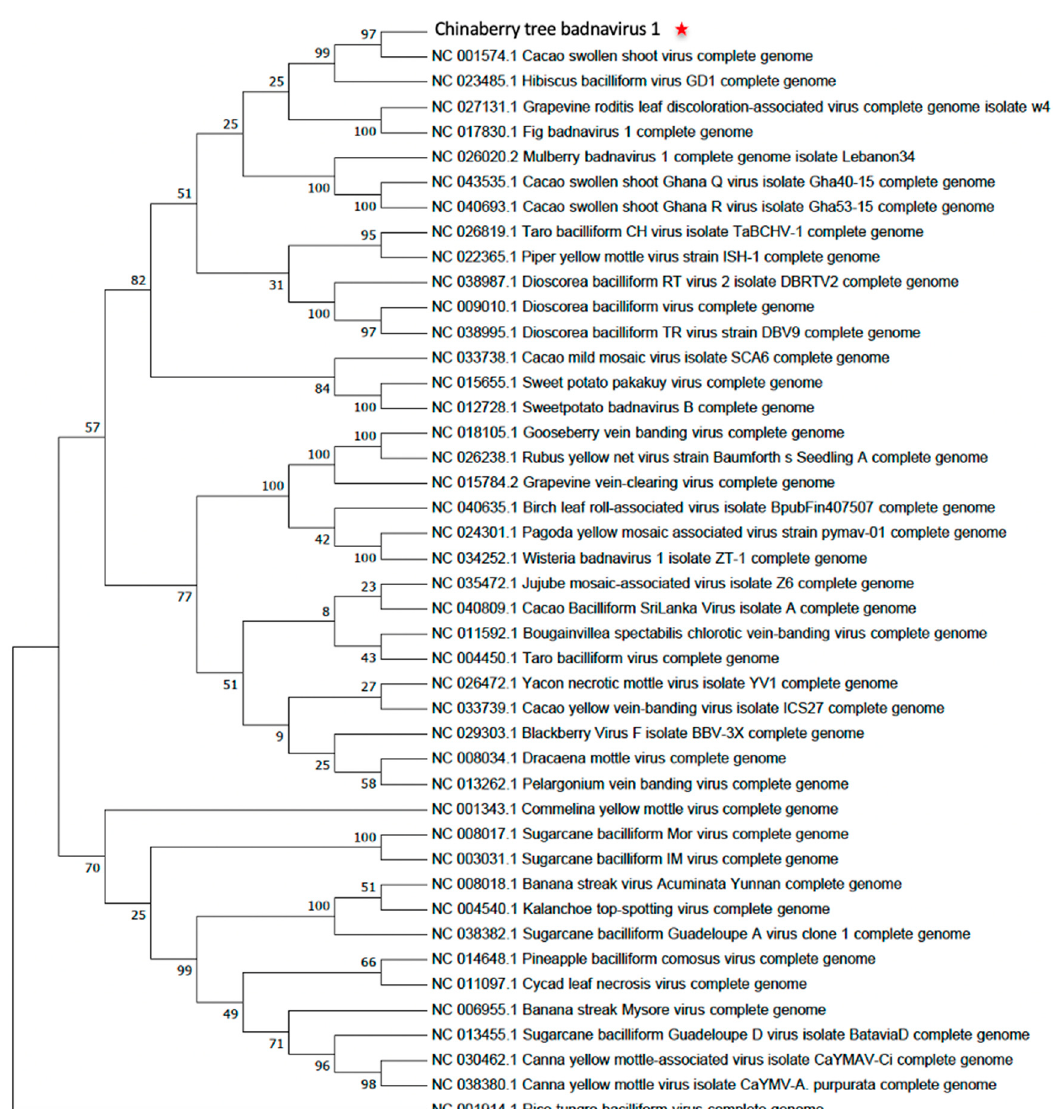
Figure 2. Neighbor-joining phylogenetic trees reconstructed from alignments of the complete genomic nucleotide sequences of ChTBV1 (Red star) with representative members of genus Badnavirus , family Caulimoviridae . The trees were constructed using the MEGA7 program (Kumar et al., 2016). Bootstrap percentage values determined from 1000 replicates are indicated at the branch internodes. GenBank accession numbers are indicated.